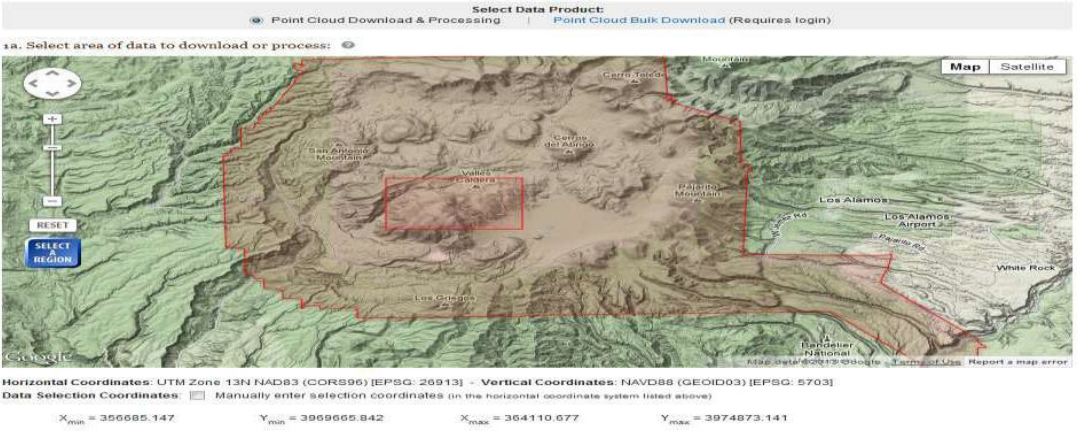
Figure 11. overall